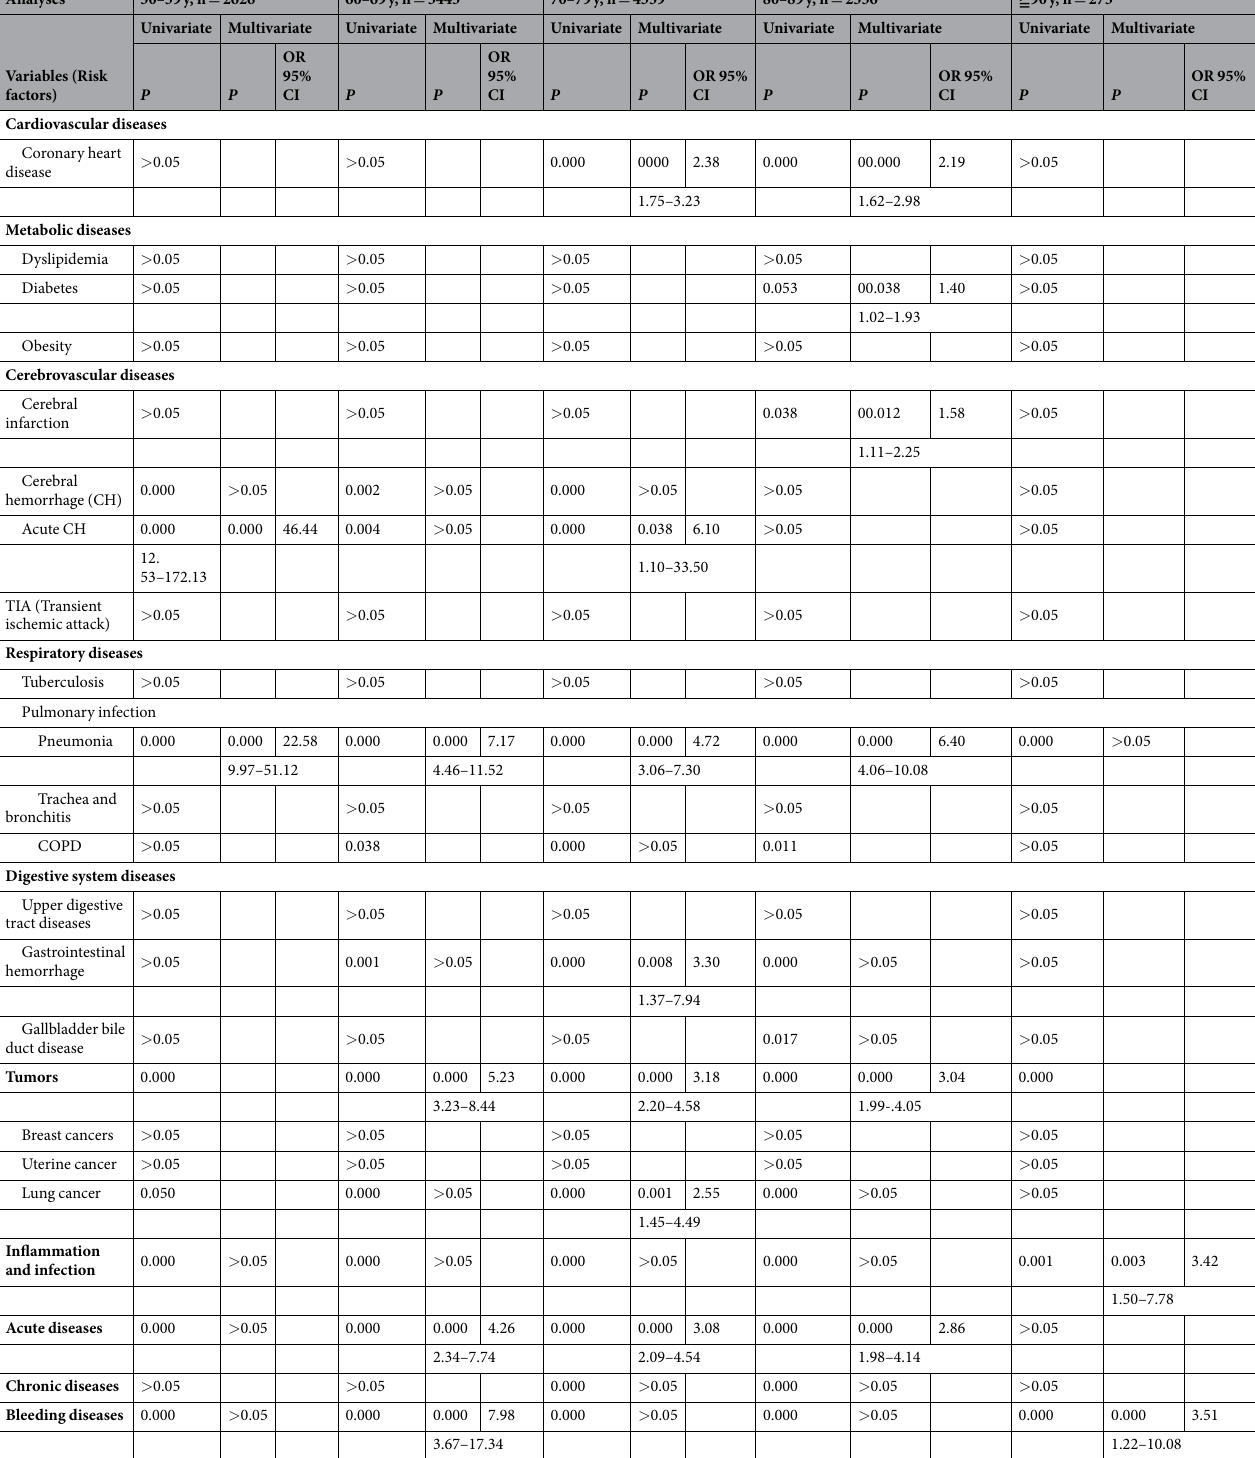
Table 2. Univariate and multivariate analyses for risk factors associated with mortality in different age groups of hypertensive women. Abbreviations represent: OR - odds ratio; CI - confidence interval; COPD - chronic obstructive pulmonary disease. Analyses include 7 subgroups, in which 6 are shown in the table; another one ( ≦ 49 y, n = 978, all P values < 0.05) is not listed. Multivariate analysis is adjusted for the other factors in the table with significance ( P < 0.05) in univariate analysis. Pneumonia and lung cancer are among significant risk factors from multivariate analyses ( P < 0.05) in certain age